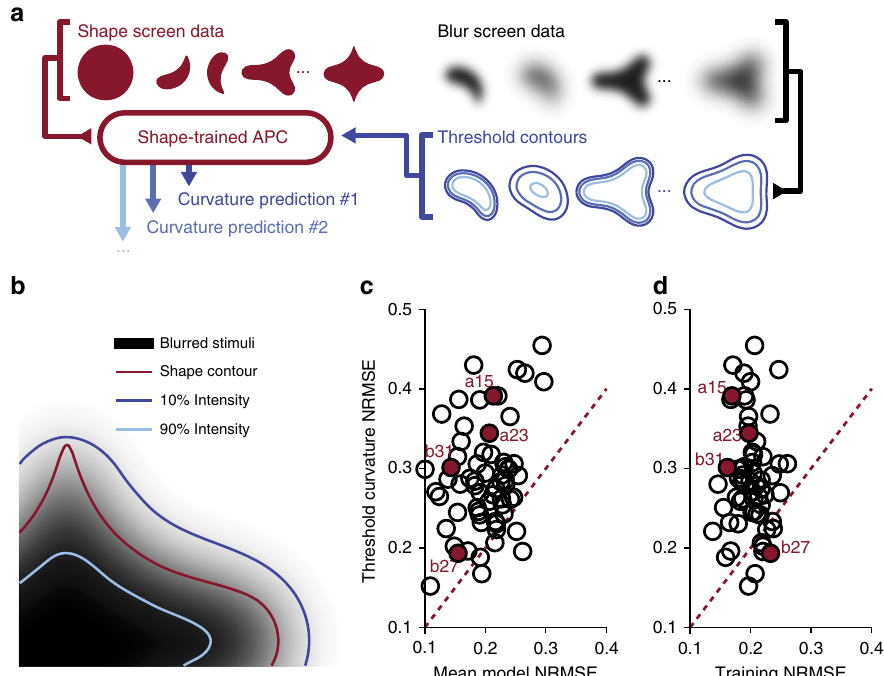
Fig. 6 Curvature modi fi cation does not explain blur selectivity. a Schematic of analysis performed across shape and blur datasets to assess the contribution of curvature modi fi cation toward blur selectivity. An APC model is fi t to data collected from shape screening (red), which then predicts responses to modi fi ed curvature threshold contours computed from blurred stimuli at different thresholds (blue). b A blurred stimulus ( β = 0.32) generated from a shape contour (red) and a family of closed contours de fi ned by the level set of an intensity threshold (blue), each with reduced curvature magnitudes. c For each cell, the minimum prediction error across all intensity thresholds (threshold curvature NRMSE; see Results) plotted as a function of a blur-invariant mean model ’ s prediction error. The latter predicts responses to different shapes in accordance with the APC model ignoring blur; responses are identical overall blur levels for a given shape. Example cells are fi lled and labeled. d Threshold prediction error as a function of bootstrapped training error, i.e.,